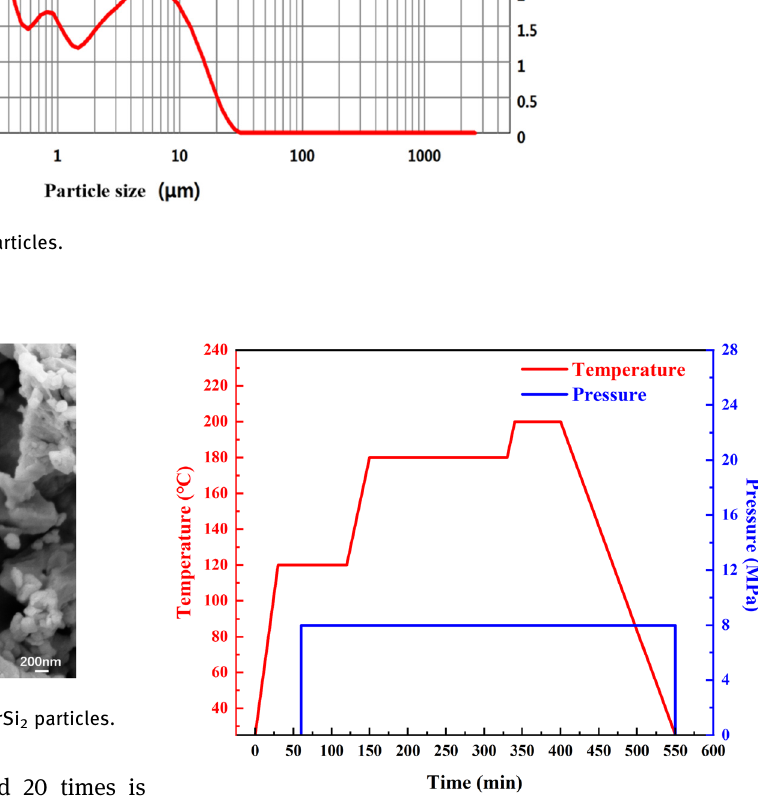
Figure 3: Curing curves of molding